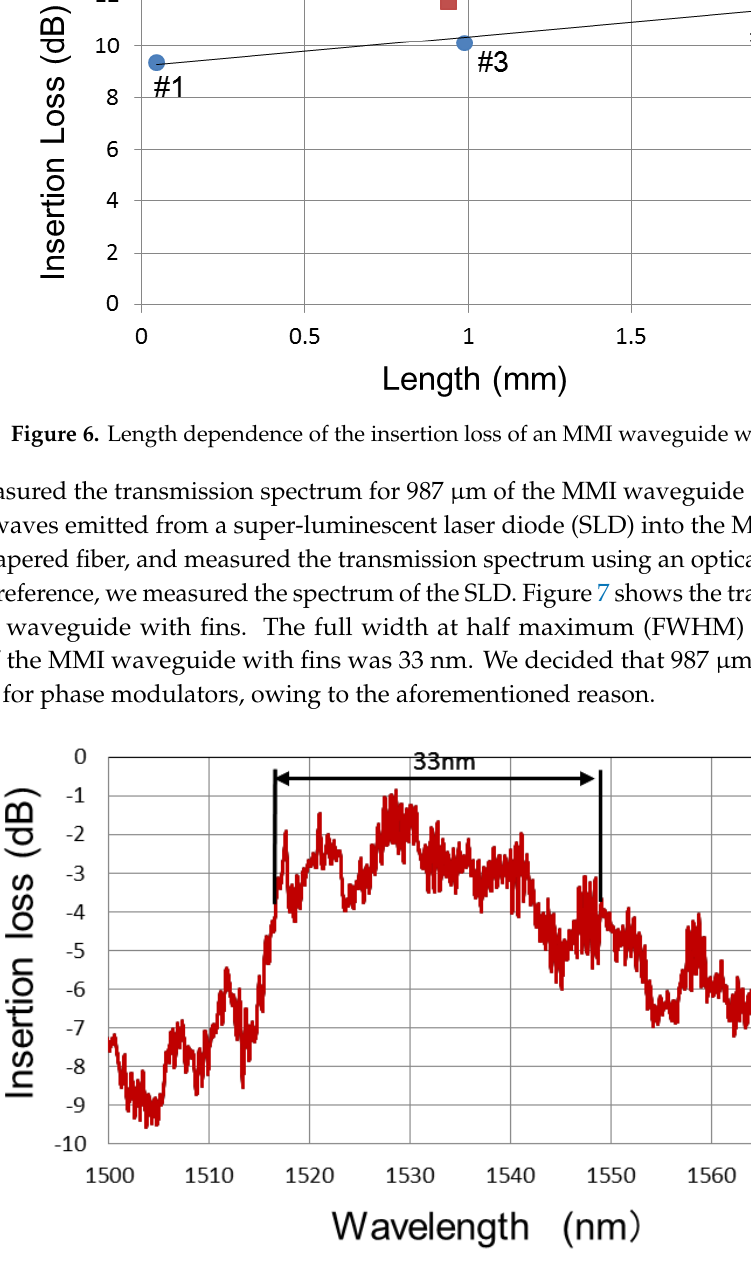
Figure 7. Transmission spectrum of an MMI waveguide with fins.